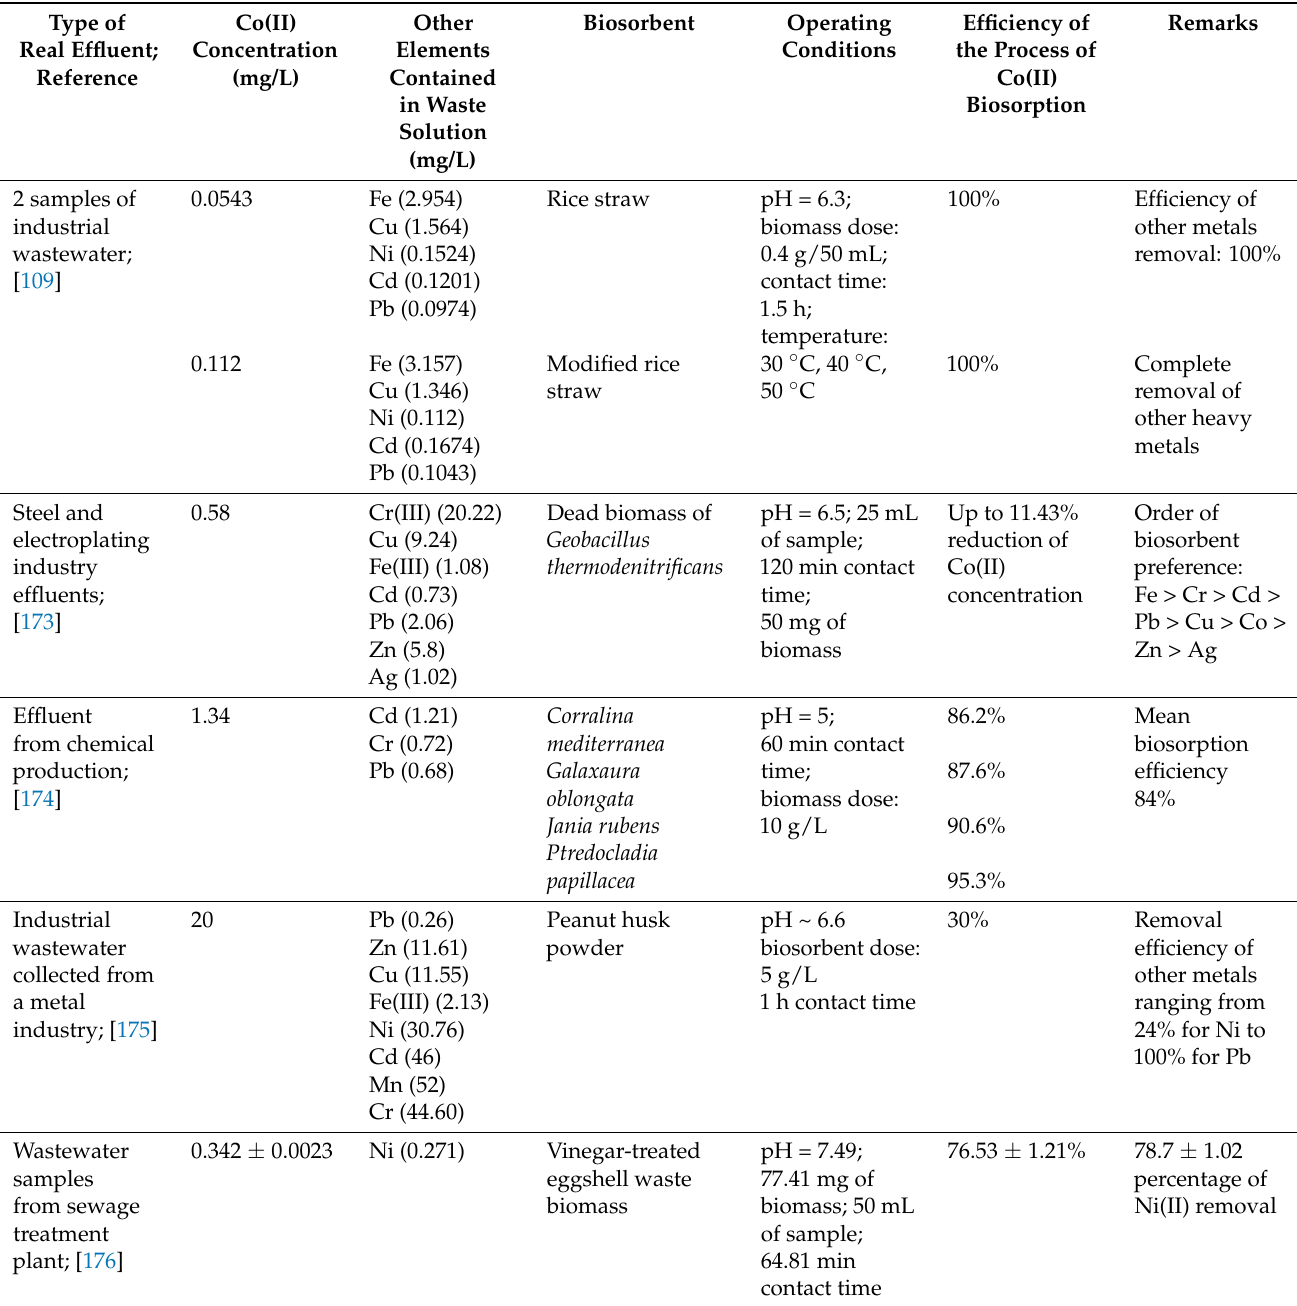
Table 6. Summary of the reports on the treatment of real wastewaters containing Co(II) by us- ing